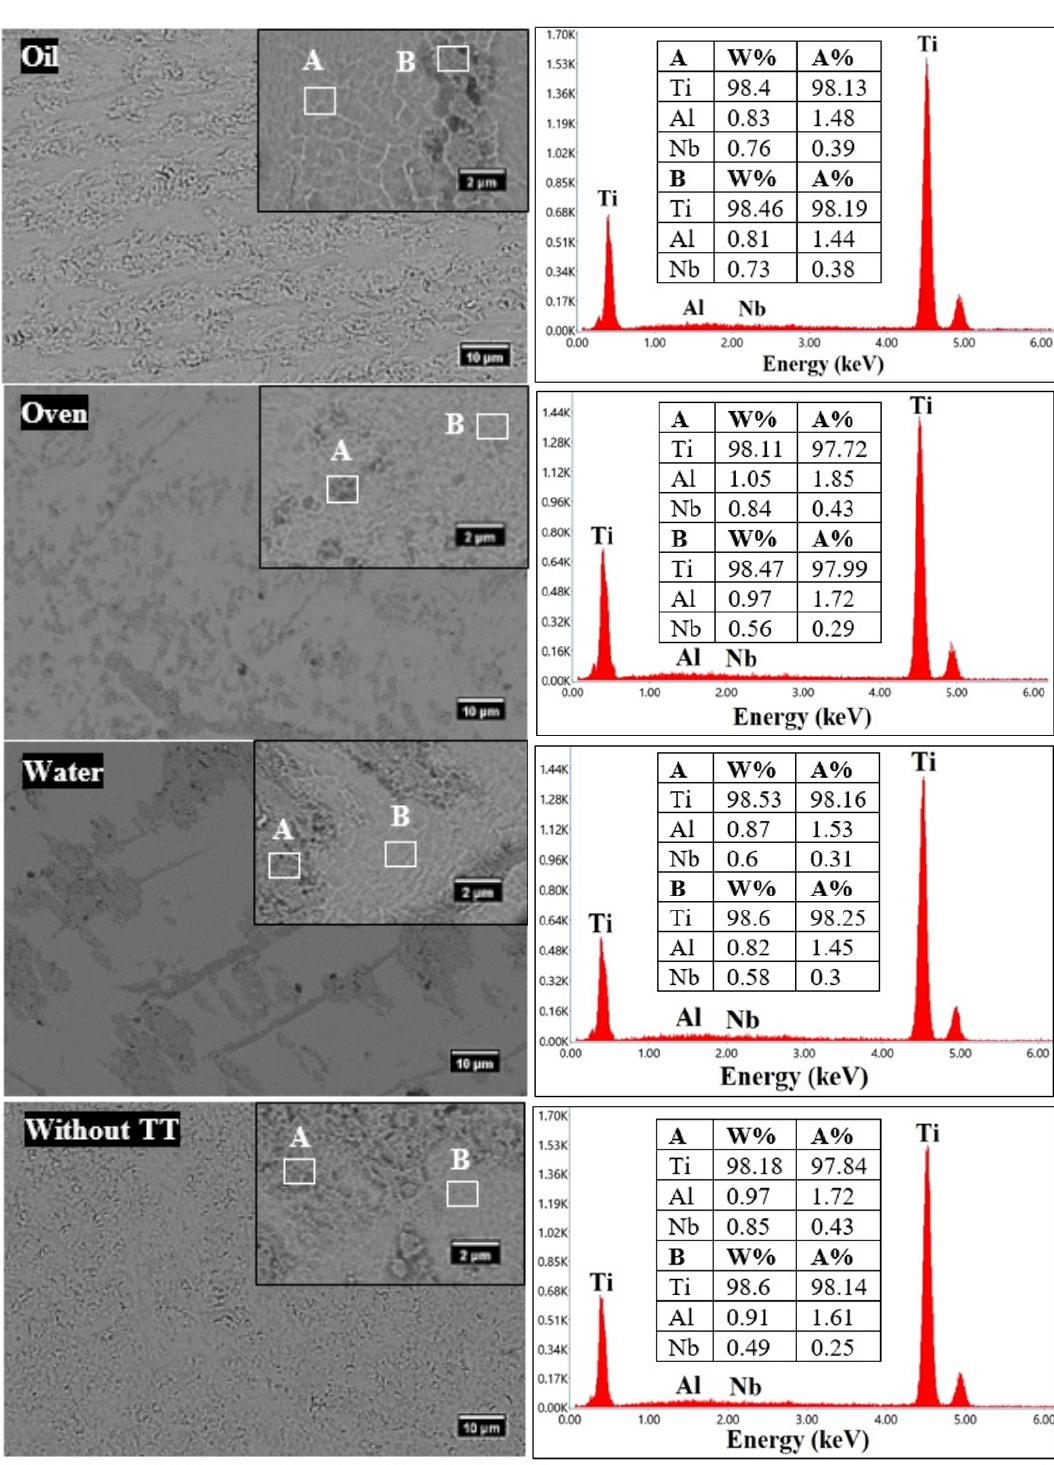
Figure 3. SEM micrographs at 1000 × magnification and at 5000 × magnification (upper right corner), EDX spectra, and